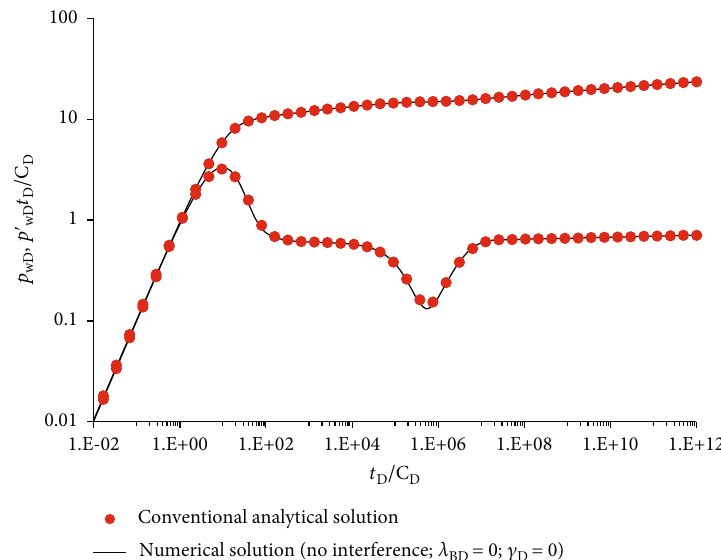
Figure 4: Comparison between the numerical solution and the analytical solution to the pressure drawdown well test.